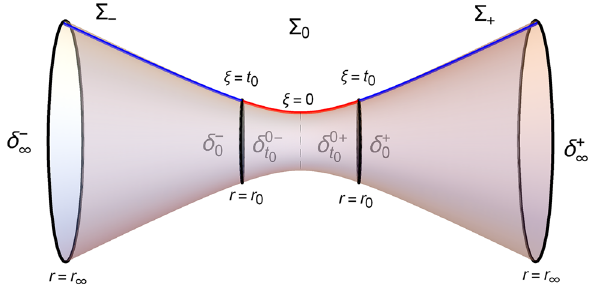
Fig. 10 Full picture of the manifold obtained after the complex exten- sion of the t 0 -slice